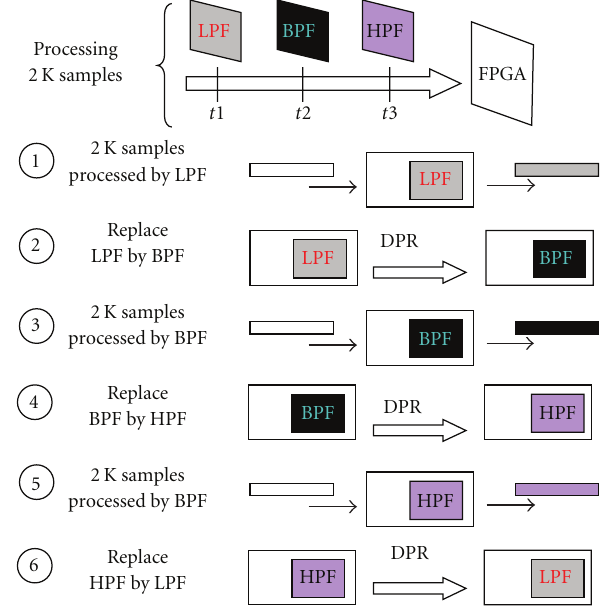
Figure 17: Filterbank data processing. LPF: low-pass filter, BPF: band-pass filter, HPF: high-pass filter.